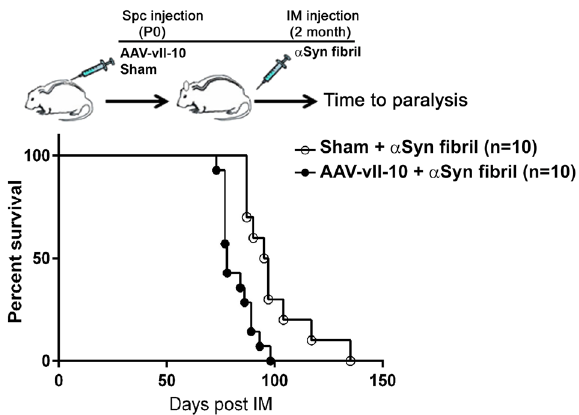
Fig. 3 Intraspinal expression of AAV-vIl-10 leads to early mortality in α Syn-seeded M83 + / − mice. M83 + / − neonates were intraspinally injected with AAV-vIl-10 or sham injected, aged to 2 months, and then injected with α Syn fi bril in hindlimb muscles at 2 months of age. The median age of survival of vIl-10-expressing mice was 78 days post α Syn fi bril injection, while the median age of sham injected mice was 96 days (log-rank test, P < 0.0019, n = 10